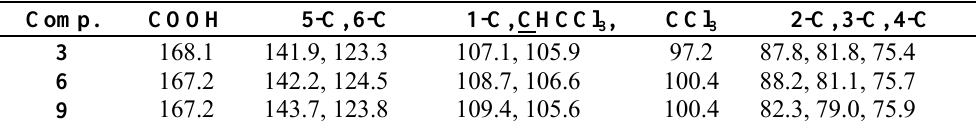
Table 2. The 13 C-NMR (100 MHz) chemical shifts ( δ ppm) of Knoevenagel-Doebner condensation products of